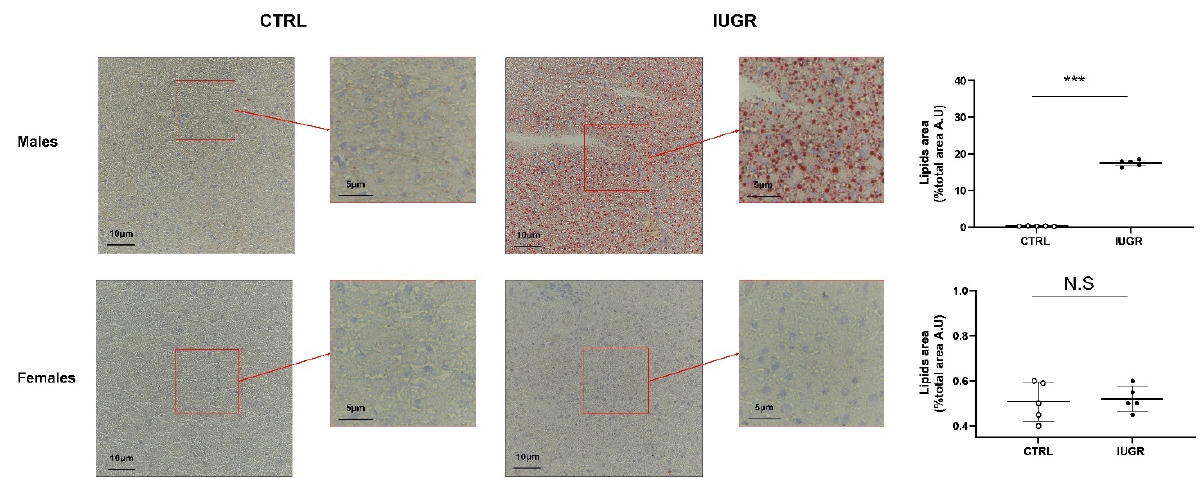
Figure 4 . Neutral lipids and triglycerides in the liver from CTRL and IUGR males and females at 6 months of age. Oil Red O staining was performed to identify neutral lipids and triglycerides in males and females. n = 5 animals/group/sex. *** p < 0.001; N.S: not significant. Magnification (40 and 60×). Scale bar = 5 and 10 µm.